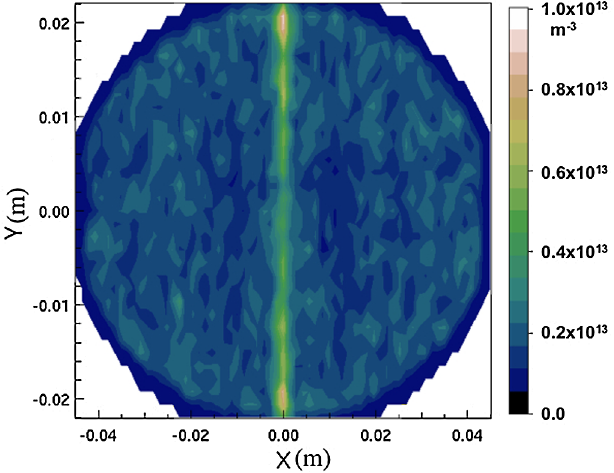
FIG. 3. Electron density in the x - y plane for all electrons with z within 3.134 mm of the maximum of B y . Snapshot in time at t ¼ 626 ns , i.e., just after the 45th